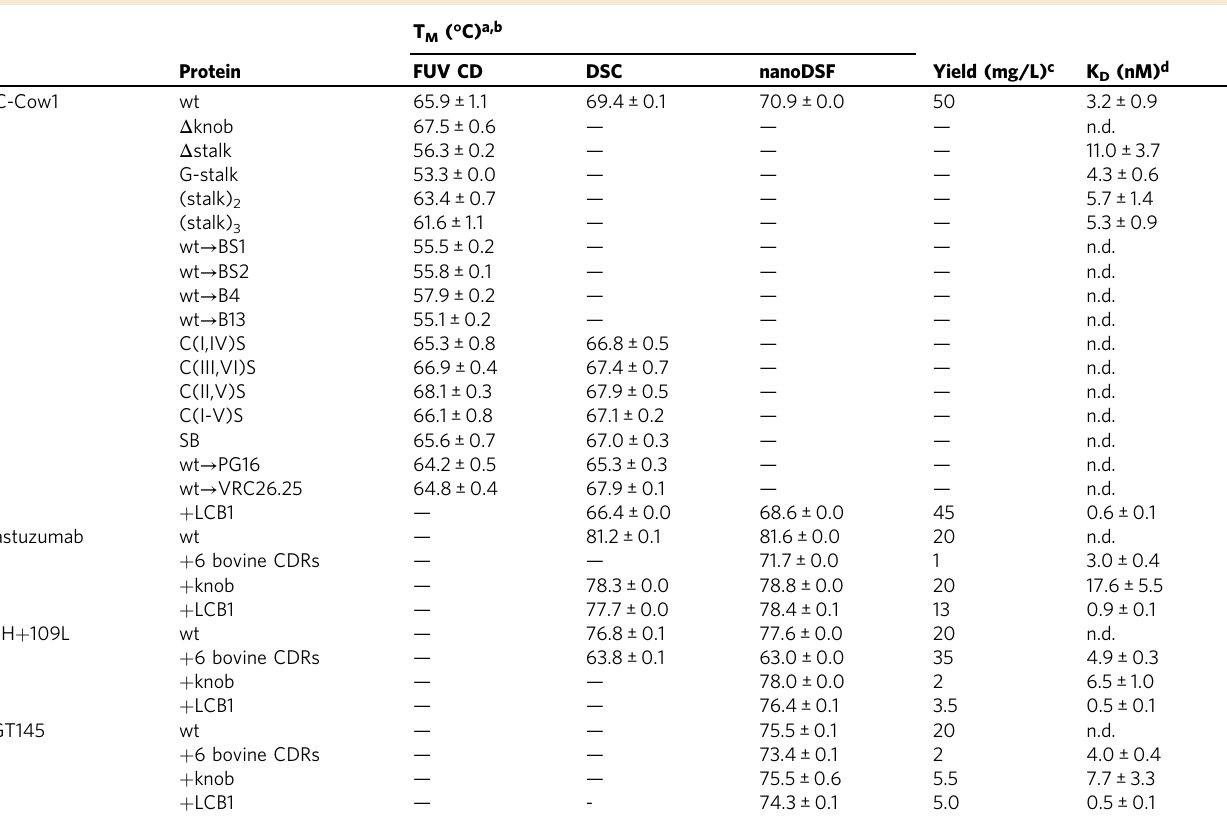
Table 1. Overview of characteristics of the bovine, human and chimeric Fab